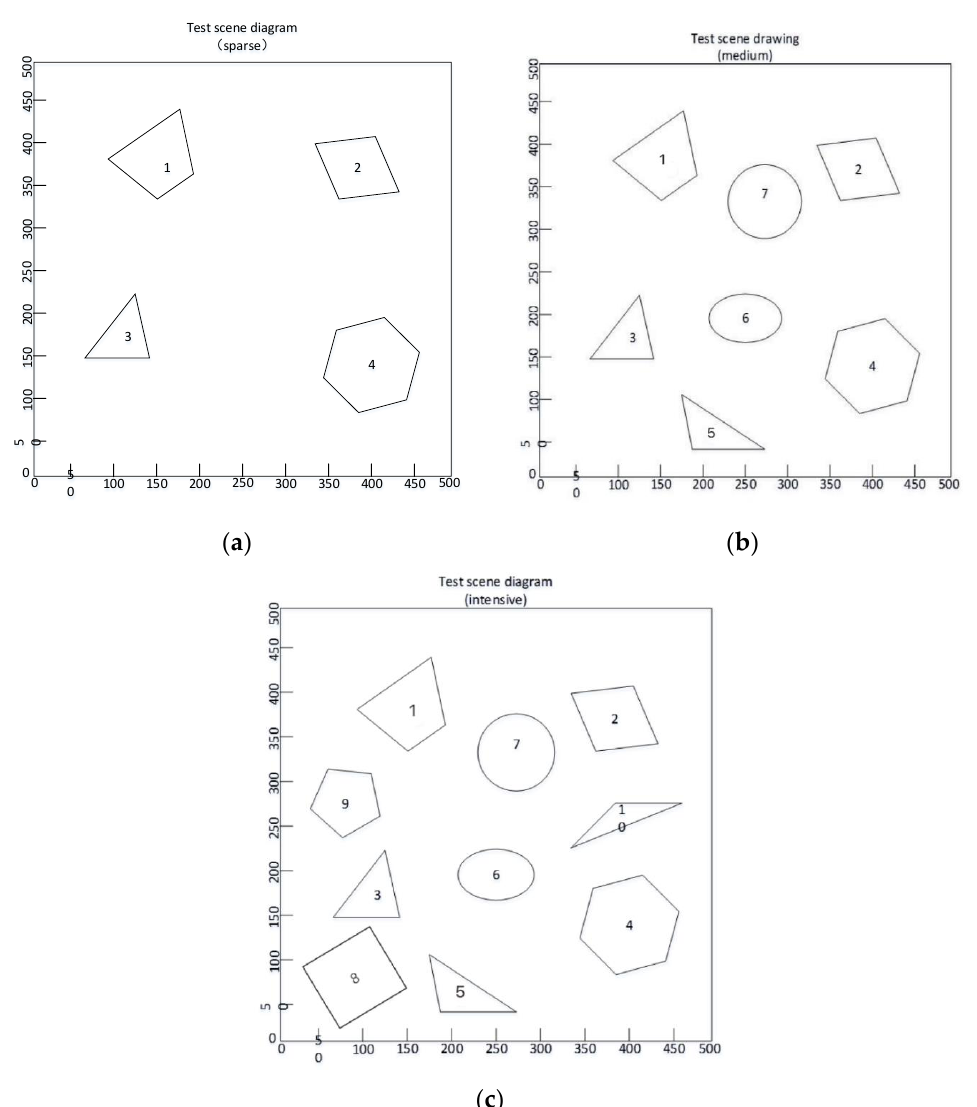
Figure 8. Simulation experiment scene of sparse, moderate, and dense obstacles. (a) Sparse obstacle simulation scene, (b) Moderate obstacle simulation scene and (c) dense obstacle simulation scene